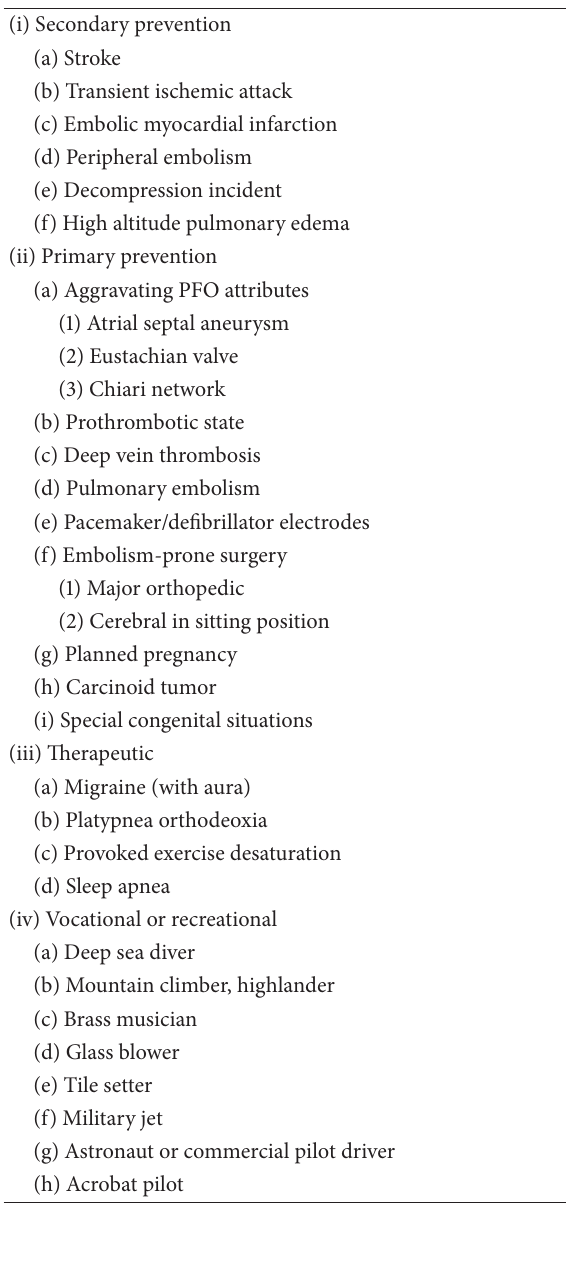
Table 1: Potential indications for PFO